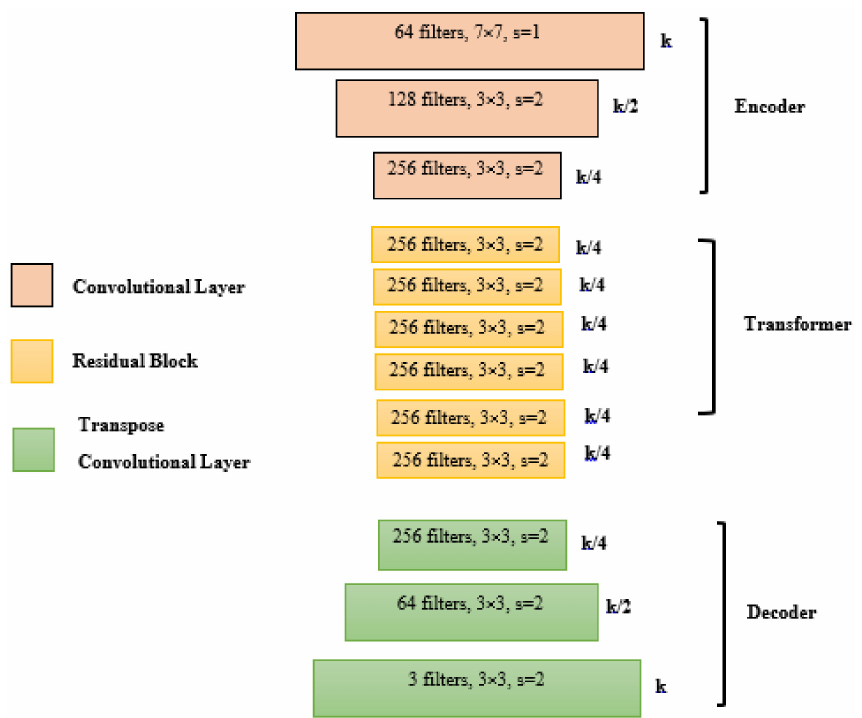
Figure 7. Discriminator